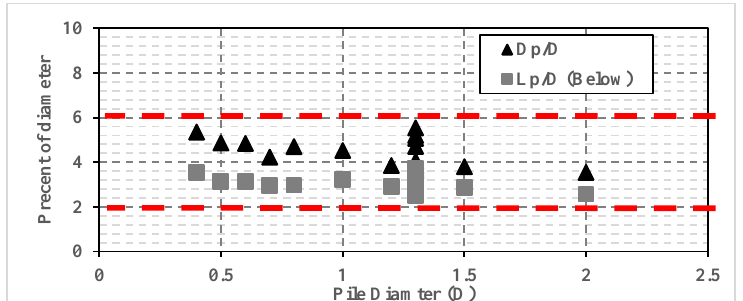
Figure 10. The ratio between the induced settlement at the failure load (S f ) and the settlement (S f-1 ) under the load before the last load increment (0.9Q ult ).